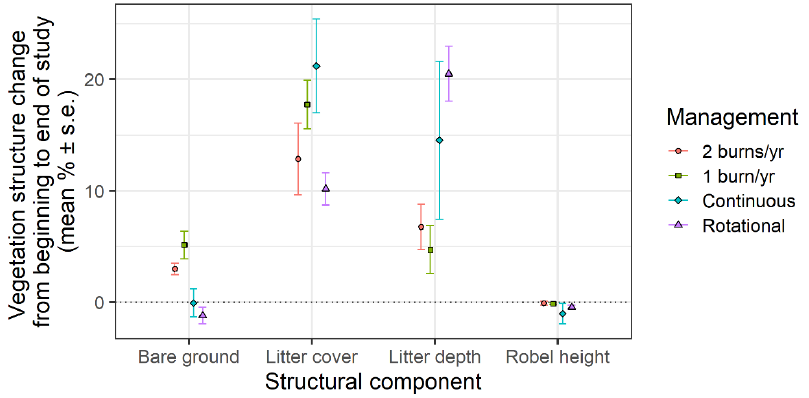
Figure 6. Changes in vegetation structure over time under four grazing regimes at the Central Grasslands Research Extension Center in Streeter, ND. Error bars represent one standard error.